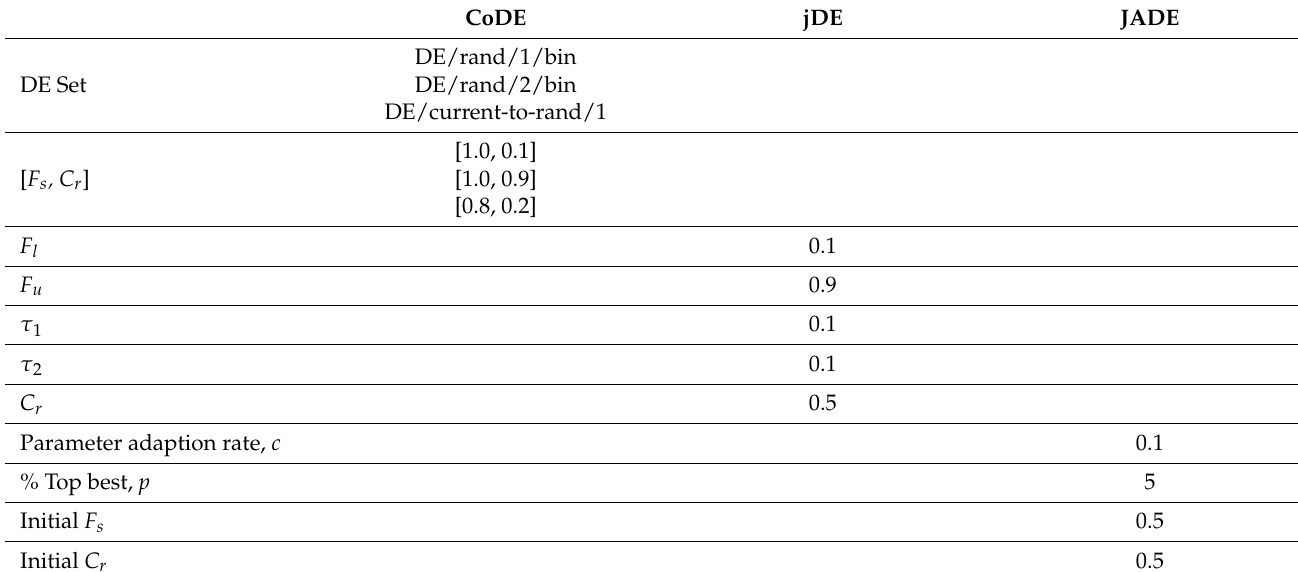
Table 2. Parameter settings for DE variants 7–9.